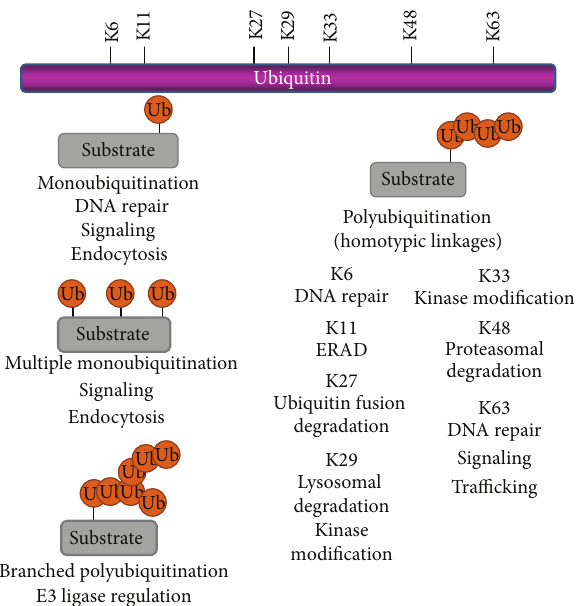
Figure 2: A schematic representation of the internal lysine residues available for Ub modification on ubiquitin as well as the different types of Ub modifications and their functional roles in the